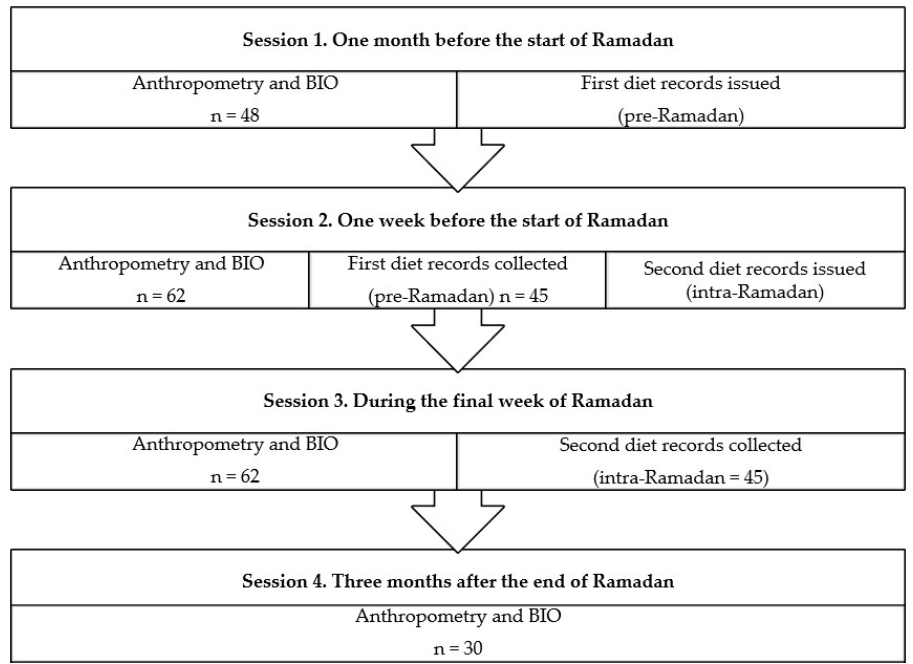
Figure 1. Study sessions. BIO: Bioimpedance.